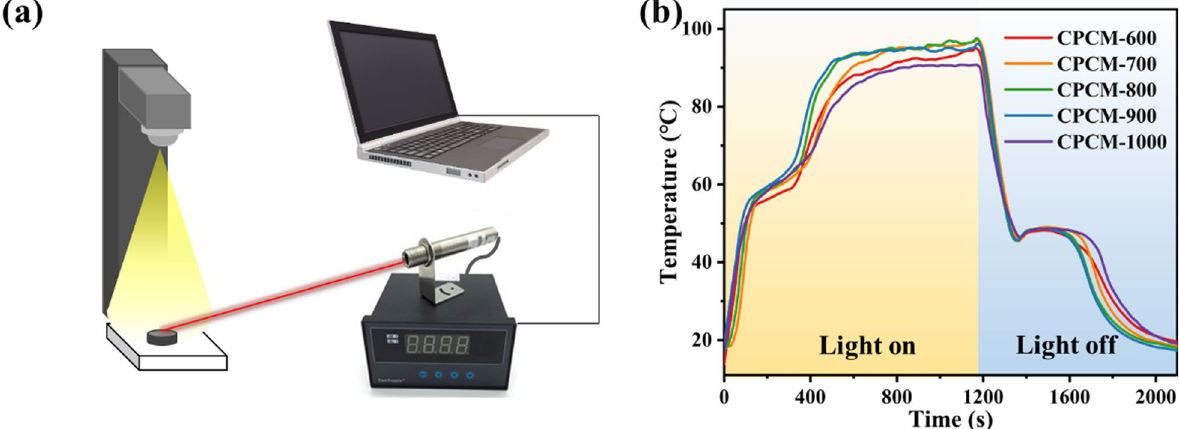
Fig. 10 The solar-to-thermal energy conversion and storage: a The schematic of the measuring system, b Solar-to-thermal conversion curves of